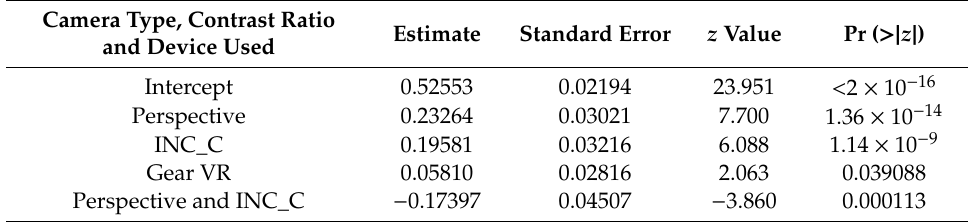
Table 34. Logistic regression results of the additive model with the variables camera type, contrast ratio, and the device used, allowing interactions of